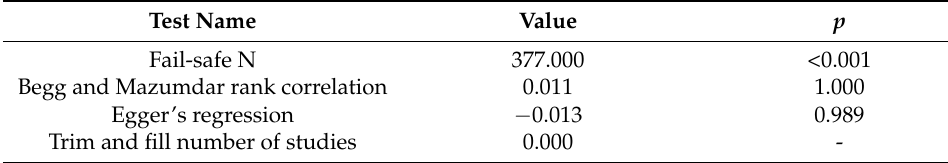
Table 1. Publication bias assessment accounting for the outlier study.